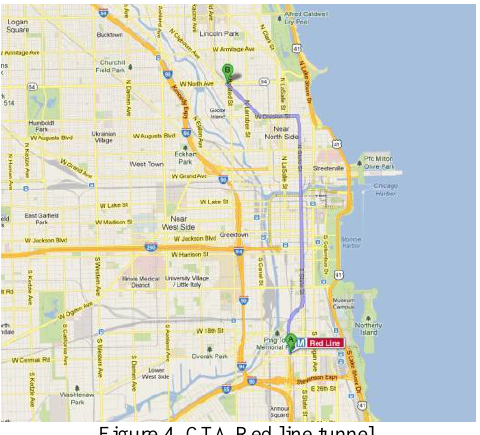
Figure 4. CTA Red line tunnel